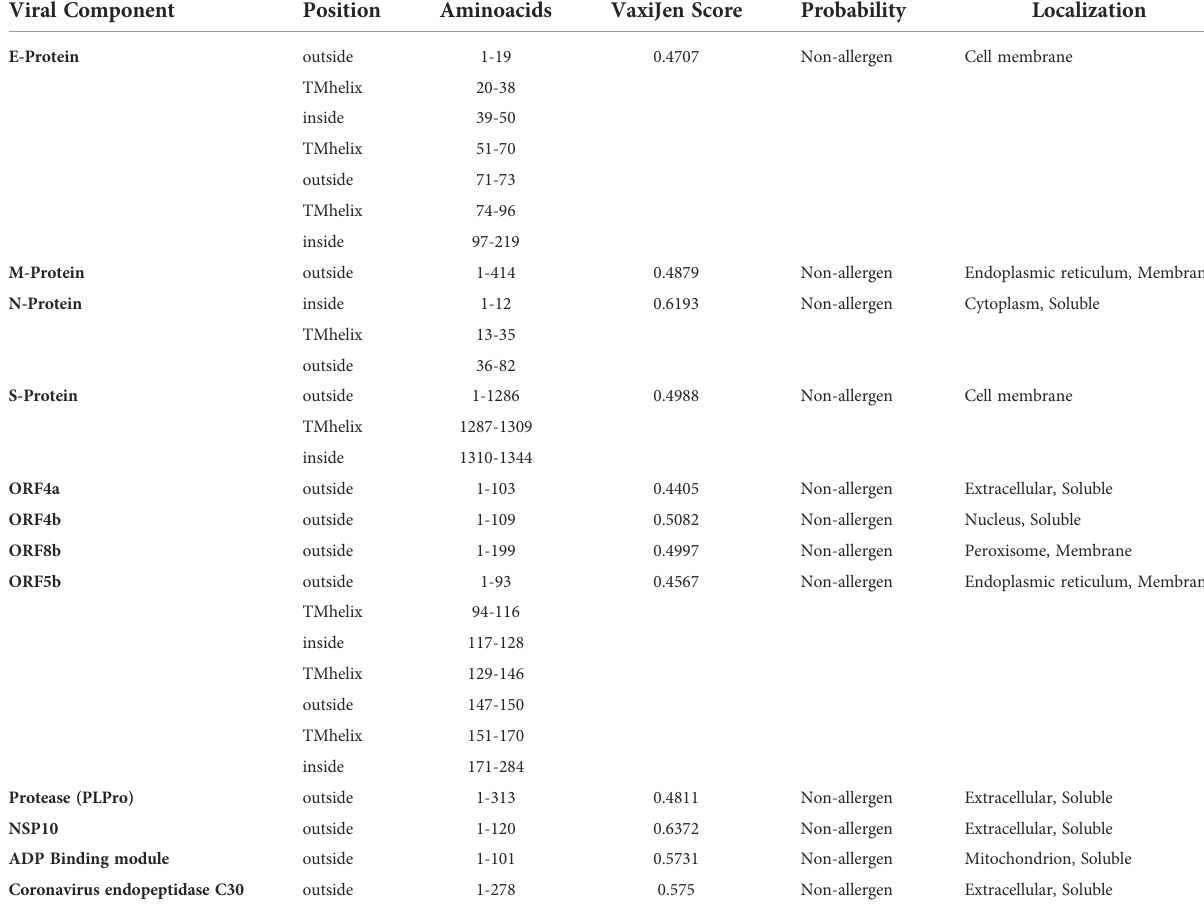
TABLE 1 NeoCoV proteins ’ antigenicity prediction (With a viral model, threshold = 0.4). The TMHMM Server v2.0 was used to predict transmembrane helices in